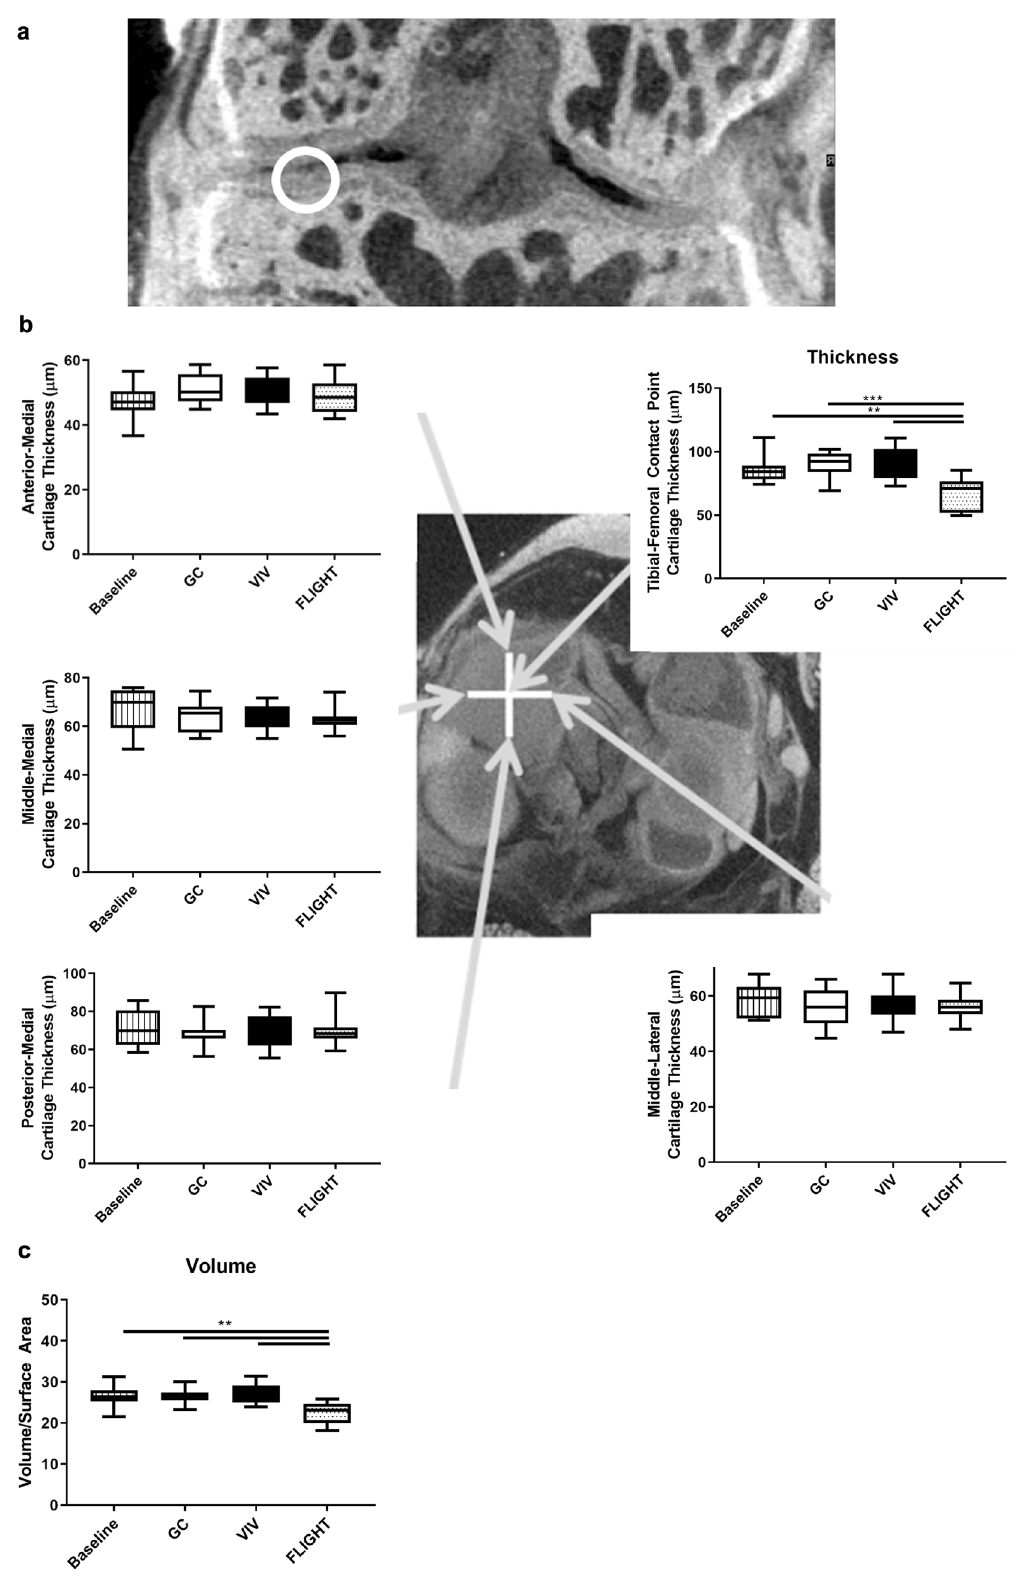
Figure 1. Decreased articular cartilage thickness at the tibial-femoral cartilage-cartilage contact point (indicated at approximately the white circle in the coronal view, and center of the white cross in the axial view, and at the end of the arrow from the upper right plot) and volume lining the medial tibial plateau occurred after spaceflight (FLIGHT) vs Ground Control (GC), Vivarium (VIV), and Baseline. ( a ) Coronal image indicating the contact point. ( b ) Cartilage thickness was lower from FLIGHT compared to controls only at the tibial-femoral cartilage contact point (upper right), but not other regions (n = 10/group). ( c ) Cartilage volume was lower after FLIGHT compared to controls (n = 10/group). ** p < 0.01, *** p <